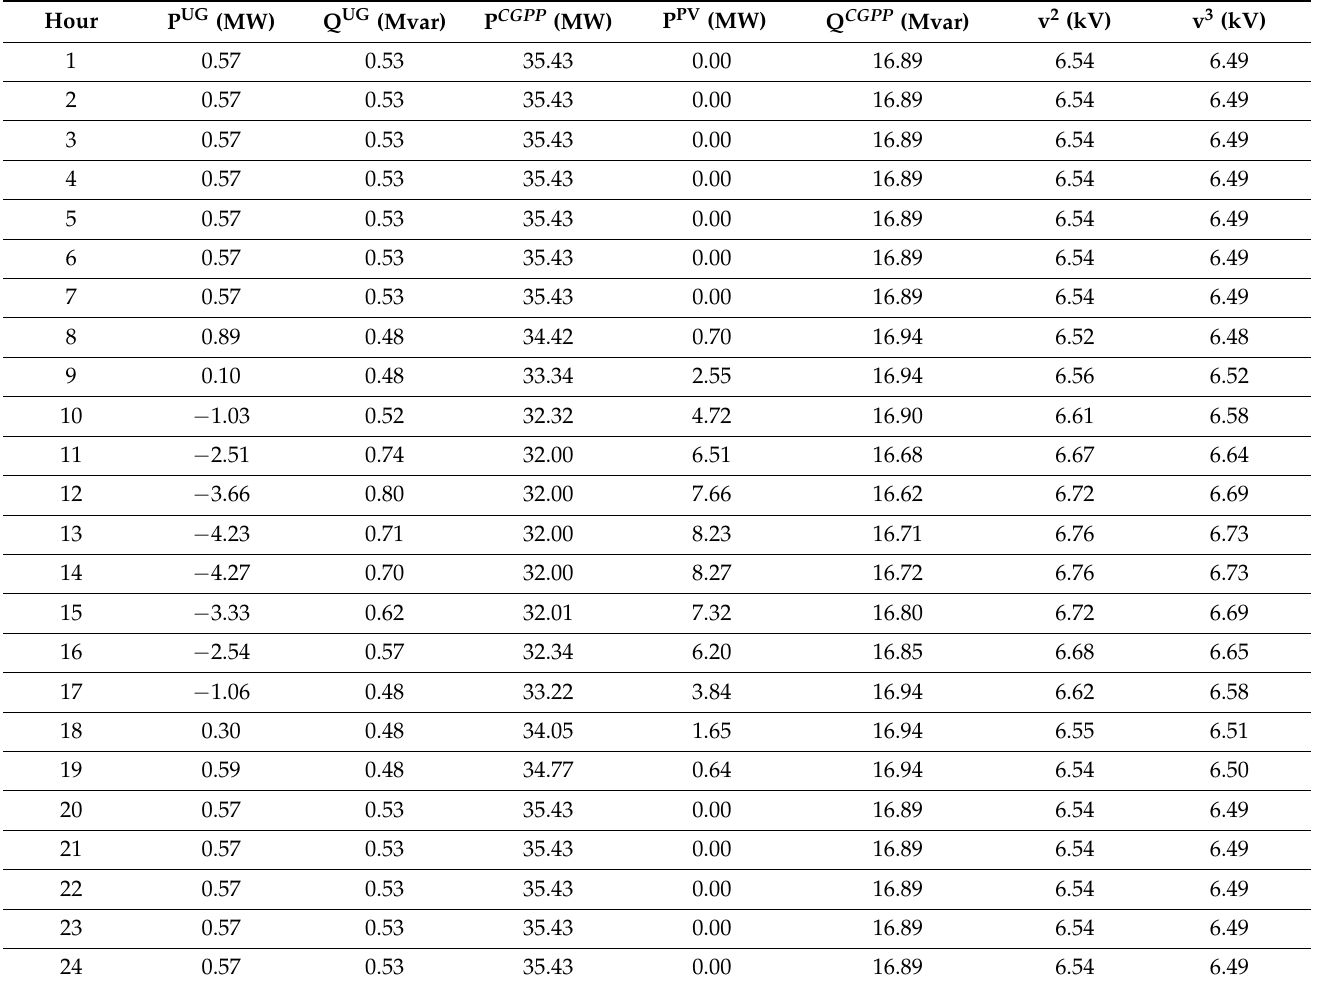
Table 7. MFA results (-ve sign indicates the export of power).